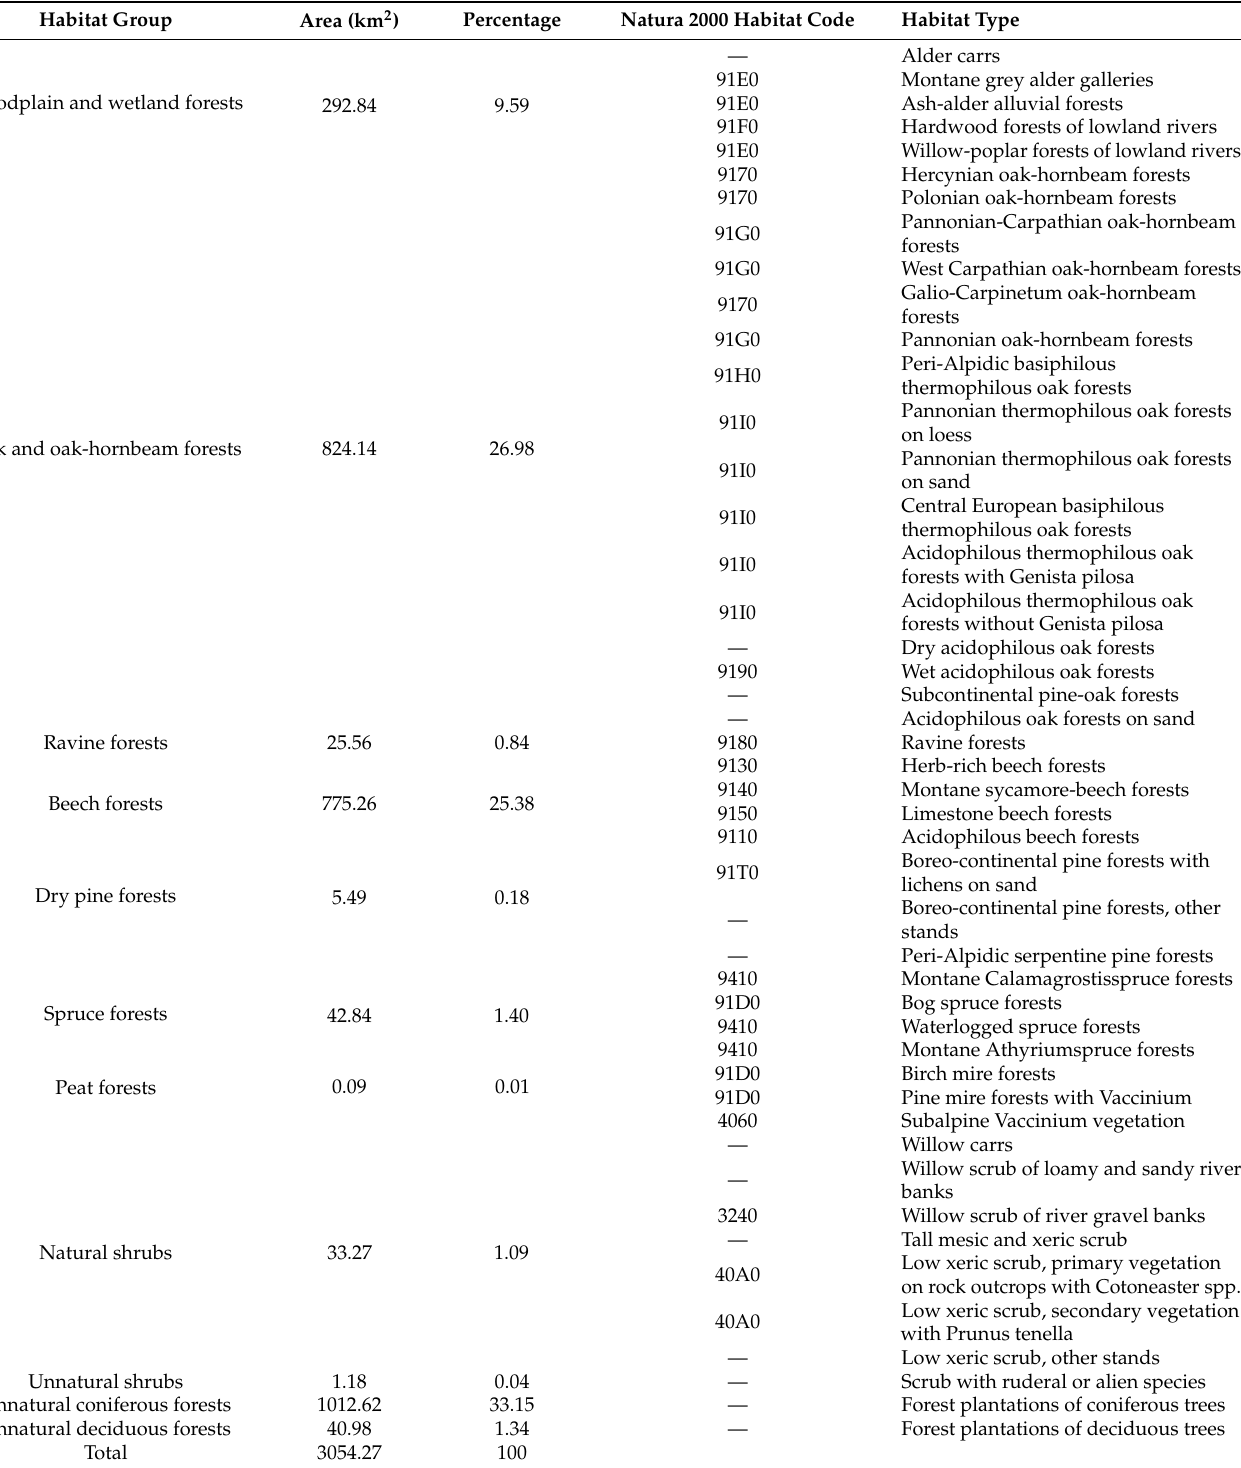
Table 2. Representation of evaluated habitats in the Morava river